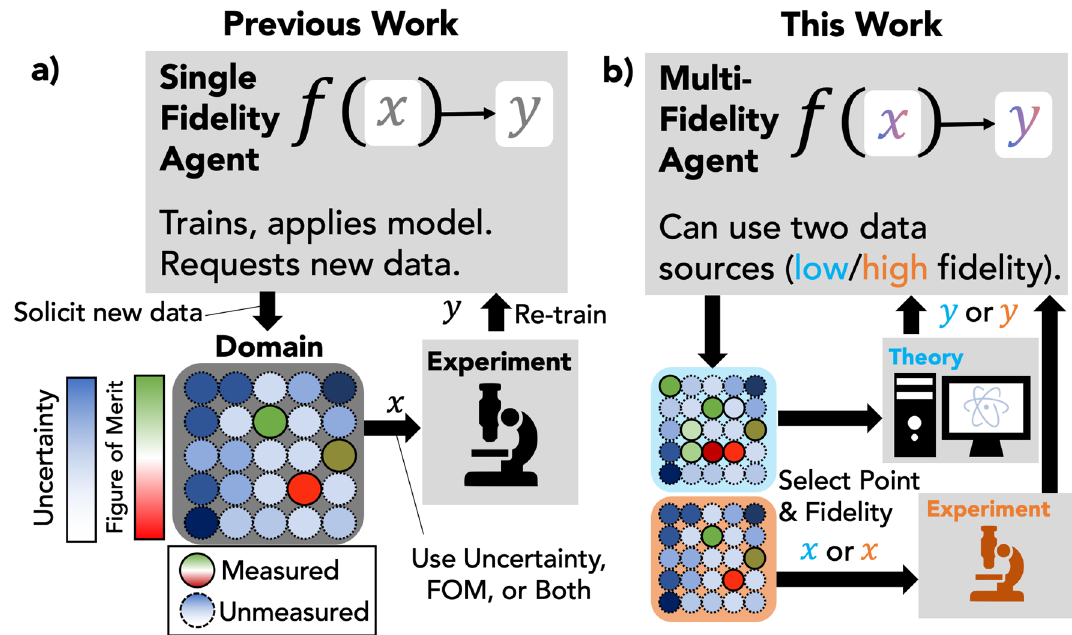
Figure 2. A schematic outlining the distinguishing features of our new multi-fidelity sequential learning framework. ( a ) Previous work established in Ref 31 . The major components of the framework include an agent, which maintains a model which is iteratively updated in response to new data selected and solicited by the agent. The agent passes the instruction to an “experiment” (a generic term for some kind of data generation, and could alternately be a theoretical calculation). ( b ) Our work is distinguished by making available two different sources of data with differing degrees of fidelity (here, we use experimental and theoretical data). The agent makes predictions using both sources of data and makes the decision to select new data from one pool or the